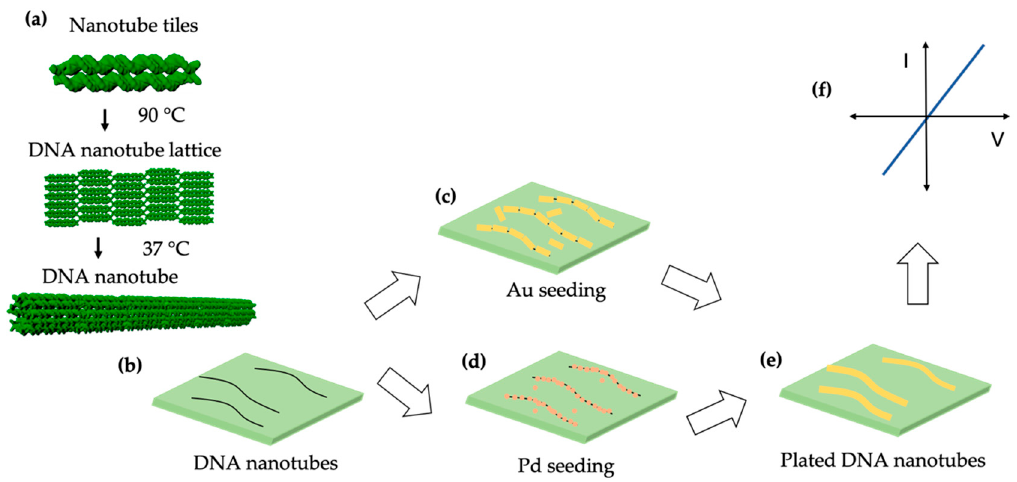
Figure 1. Schematic overview. ( a ) DNA nanotube assembly. ( b ) DNA nanotubes on an oxidized Si wafer. DNA nanotubes seeded with ( c ) Au or ( d ) Pd. ( e ) Plated DNA nanotubes. ( f ) I-V measurement.